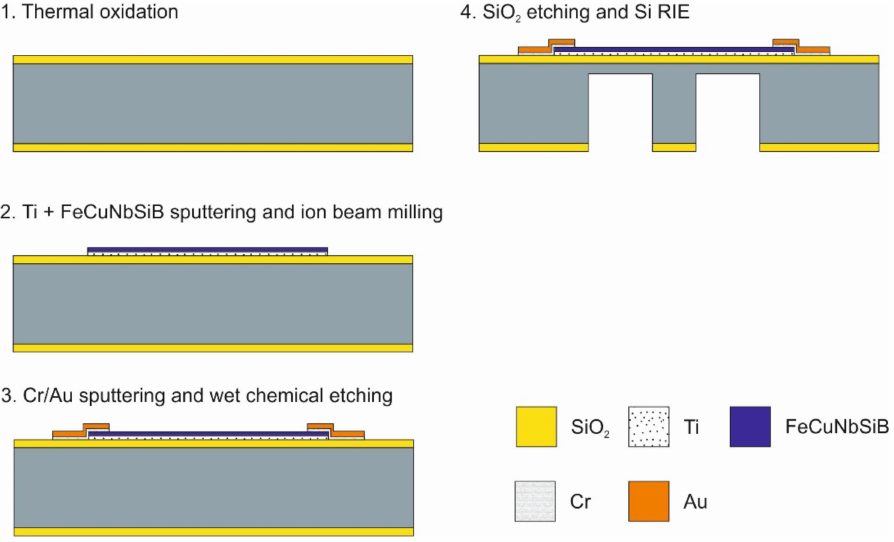
Figure 4. Process flow of the fabrication of the force sensor—shown by its cross-section. A 500- µ m-thick (100 mm diameter) double-sided polished Si wafer was used as